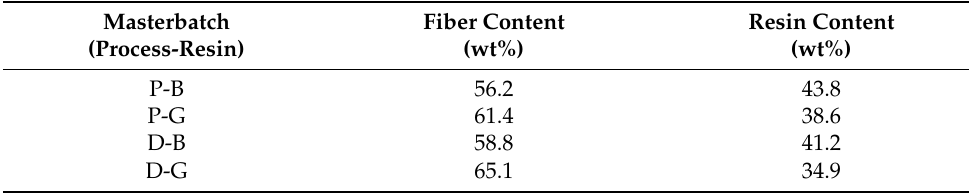
Table 1. Fiber and resin weight contents of the GF/PA6